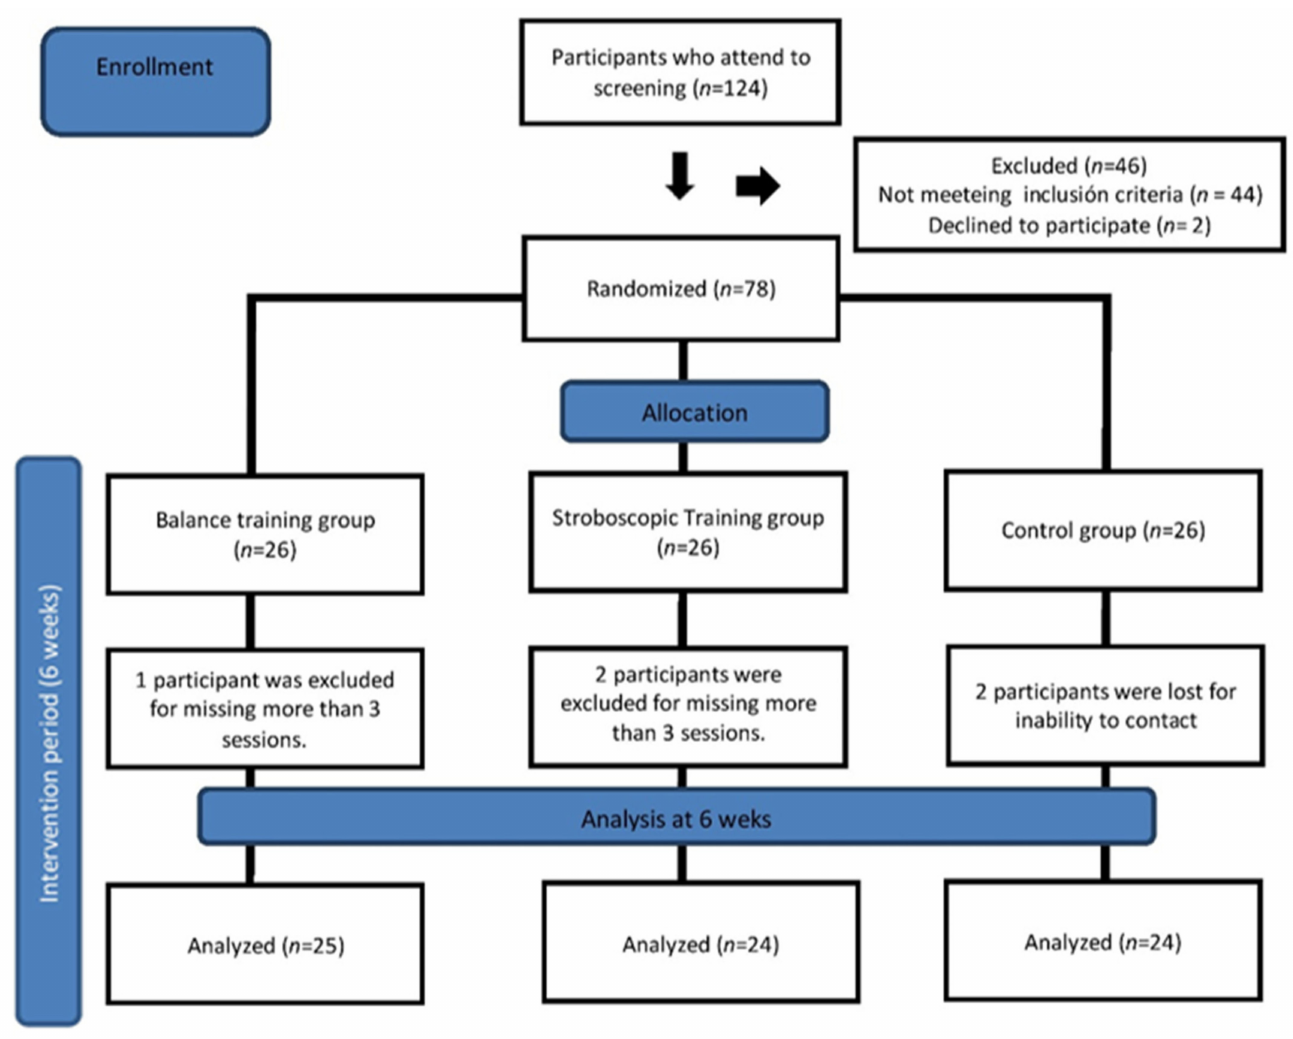
Figure 1. Flow chart of the study design and participants’ follow up through the